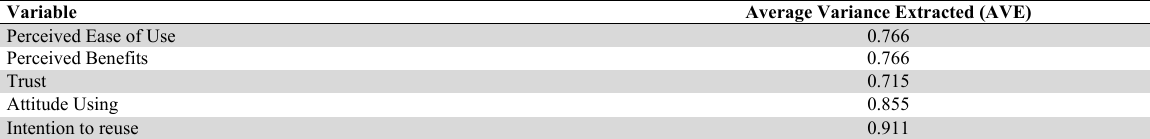
Discriminant Validity